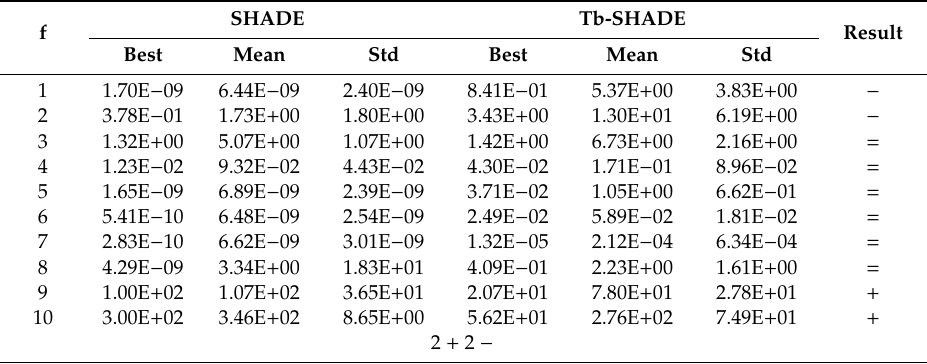
Table 7. SHADE vs. Tb-SHADE on CEC2020 in 5 D .